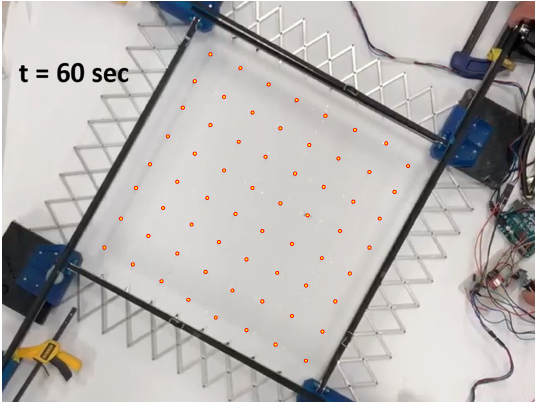
Figure 16. Stretch at 60 s. Red-outlined circles indicate sensor node